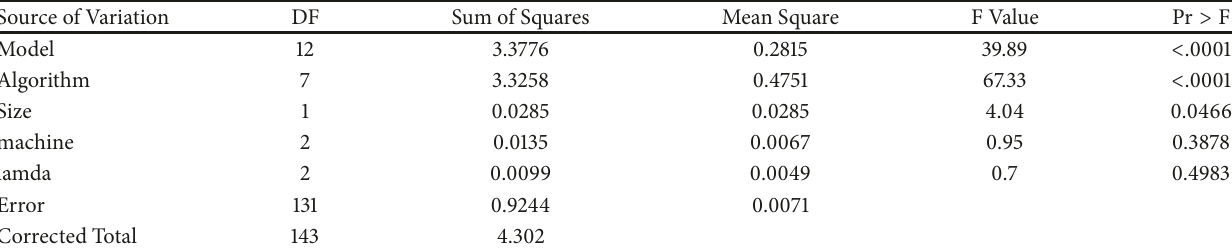
Table 8: ANOVA for the RPD for large number of orders.